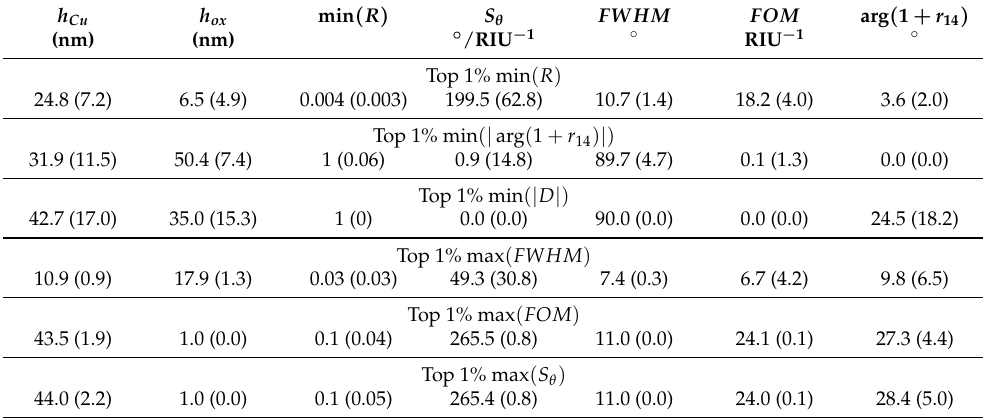
Table 4. Optimal thicknesses for the top 1% performance parameters of the SPR set up in the wet case according to the minimum of reflectance, sensitivity, full width at half maximum, figure of merit and argument of the total field on the glass–copper interface. In brackets, standard deviation of the top